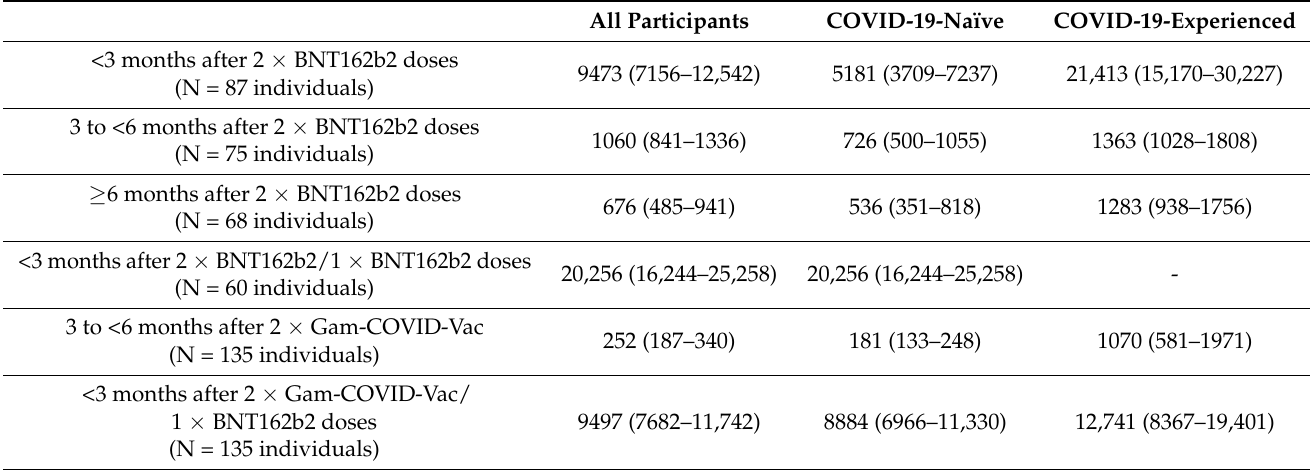
Table 3. Immunogenicity results of different vaccination schemes at different time